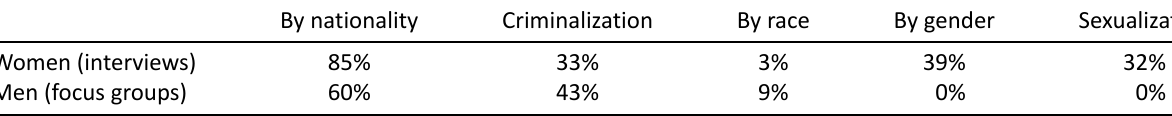
Table 3. Type of discrimination by gender (qualitative data). By